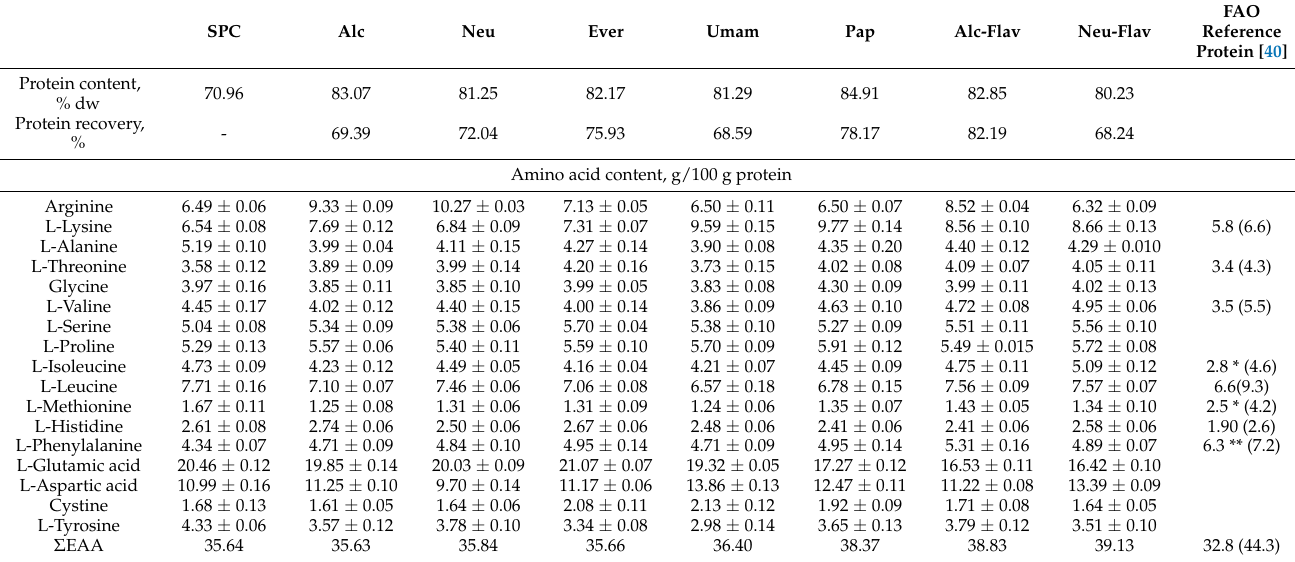
Table 1. Protein content, protein recovery and total amino acid content (g/100 g protein) in control sample (SPC) and hydrolysates obtained with different proteases. Results are expressed as means ± standard deviation ( n =